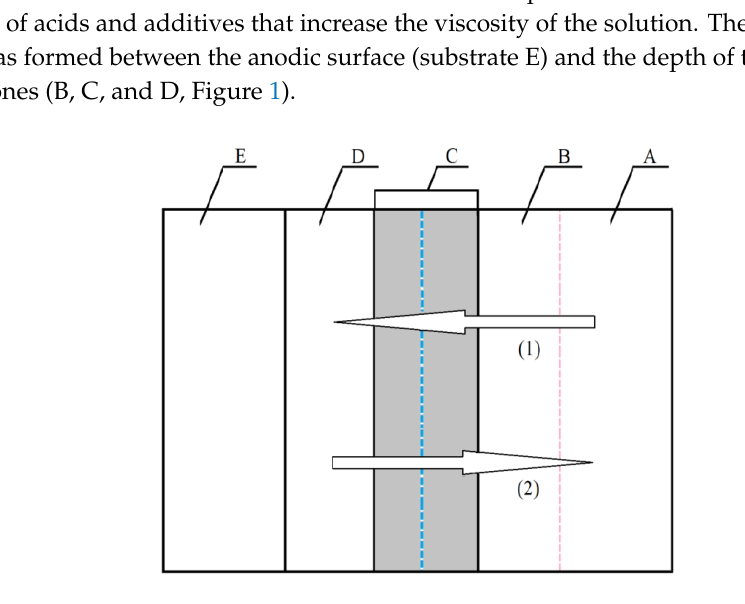
Figure 1. Model of anodic dissolution in the EP process (1) direction of acceptor movement, (2) direction of movement of metal ions [33,34].